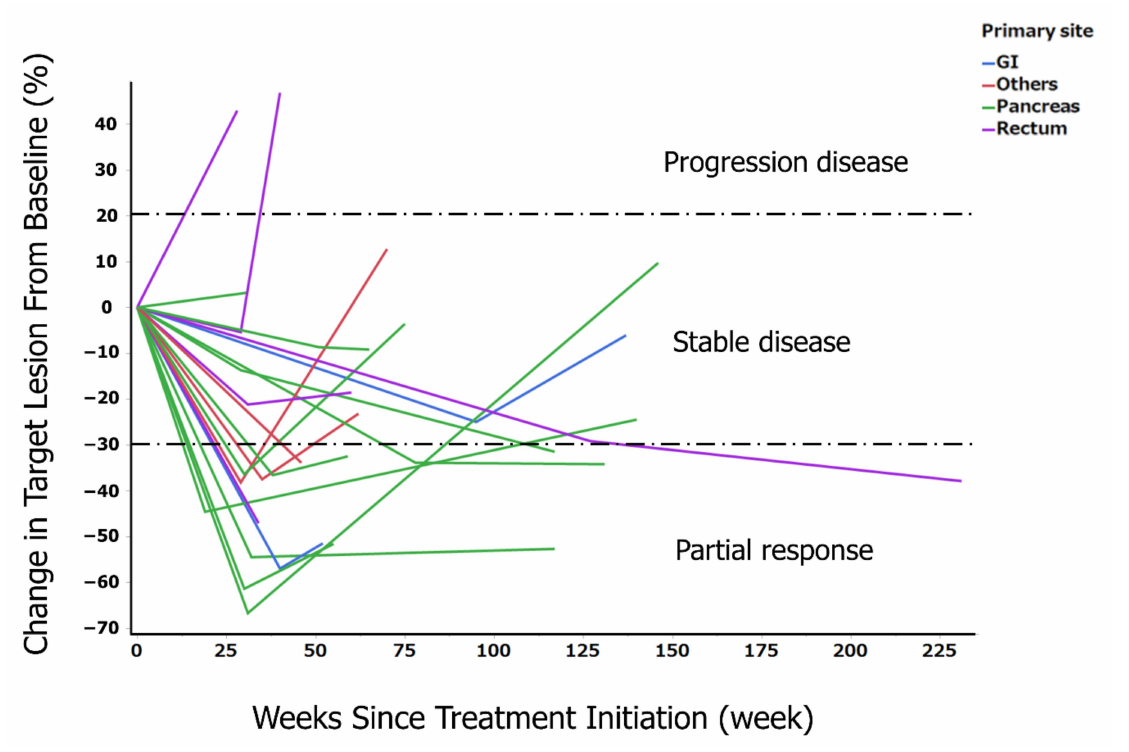
Figure 3. Spider plot showing the change in sum of tumor diameters based on RECIST in the 20 patients. RECIST, Response Evaluation Criteria in Solid Tumors guideline version 1.1; green line, primary site of pancreas; blue line, primary site of gastrointestinal tract; purple line, primary site of rectum; red line, primary site of